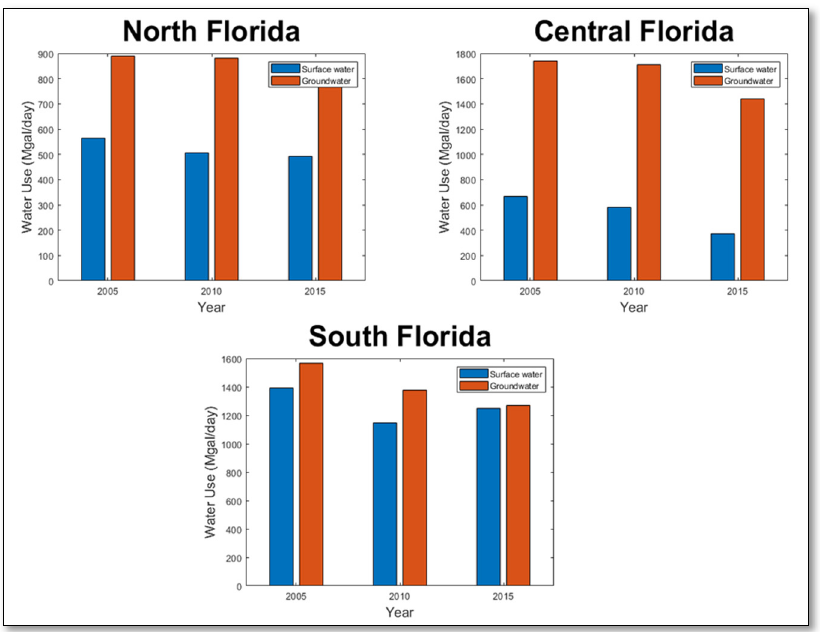
Figure 10. Comparison of water use by source (surface and groundwater) in north, central and south Florida.